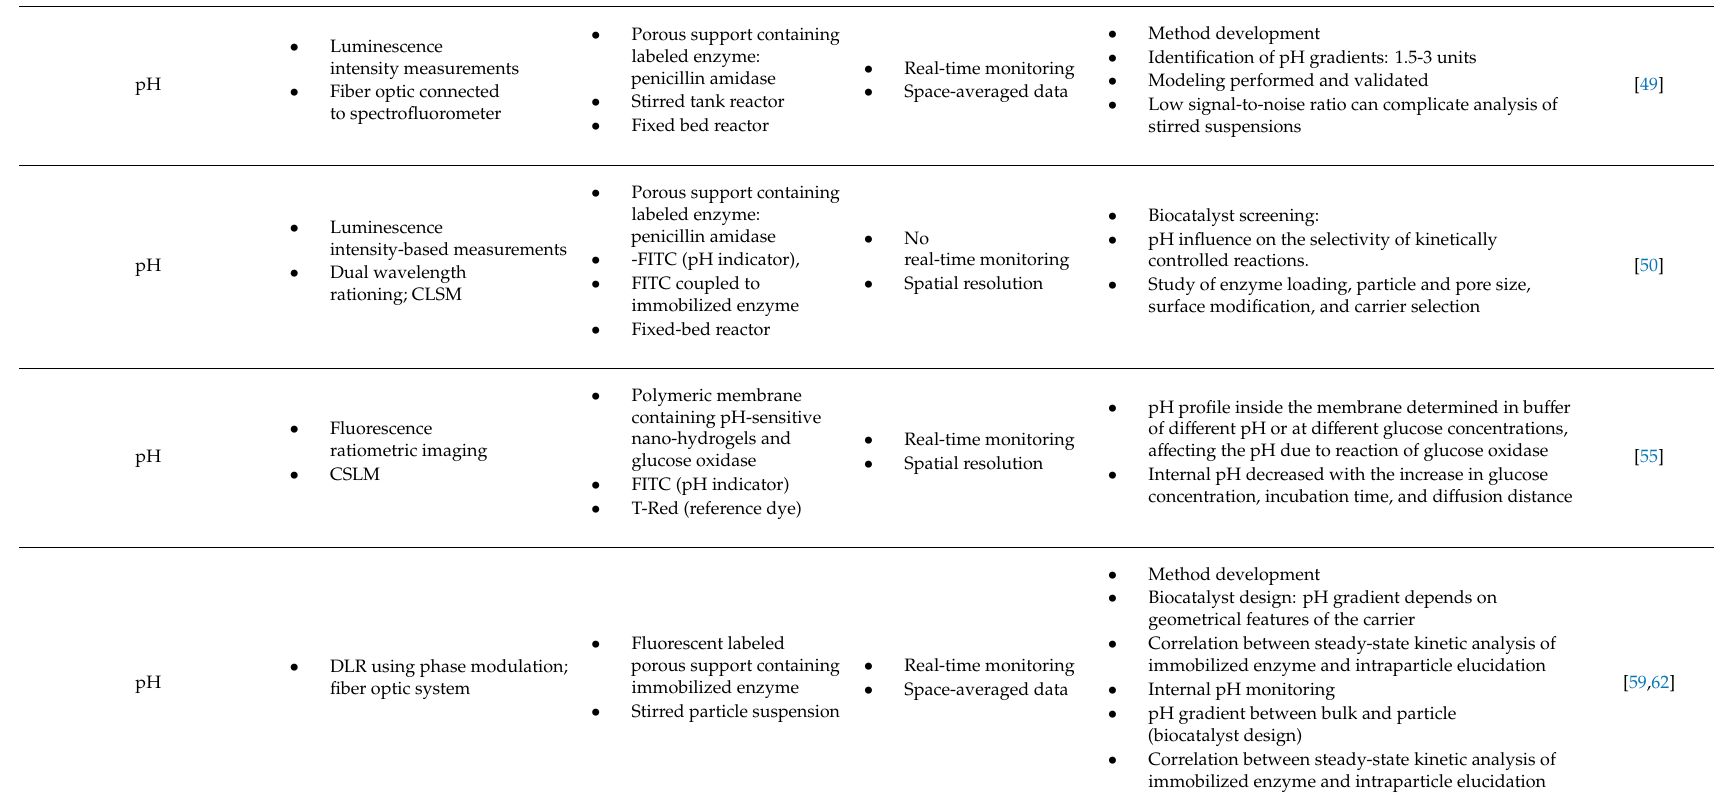
Table 1. Internal opto-chemical sensing in heterogeneous